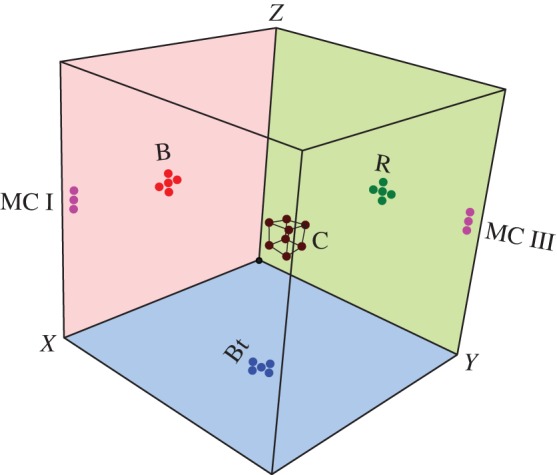
The real-space probe locations in the three-dimensional cubical box of our simulation. The probe locations are labelled as the back (B), right (R), bottom (Bt), middle corners (MC-I, MC-III) and centre (C), respectively. There are five probes near the wall centres, three probes in the middle corners and nine probes at the centre and vertices of a small cube placed at the centre of the cube.